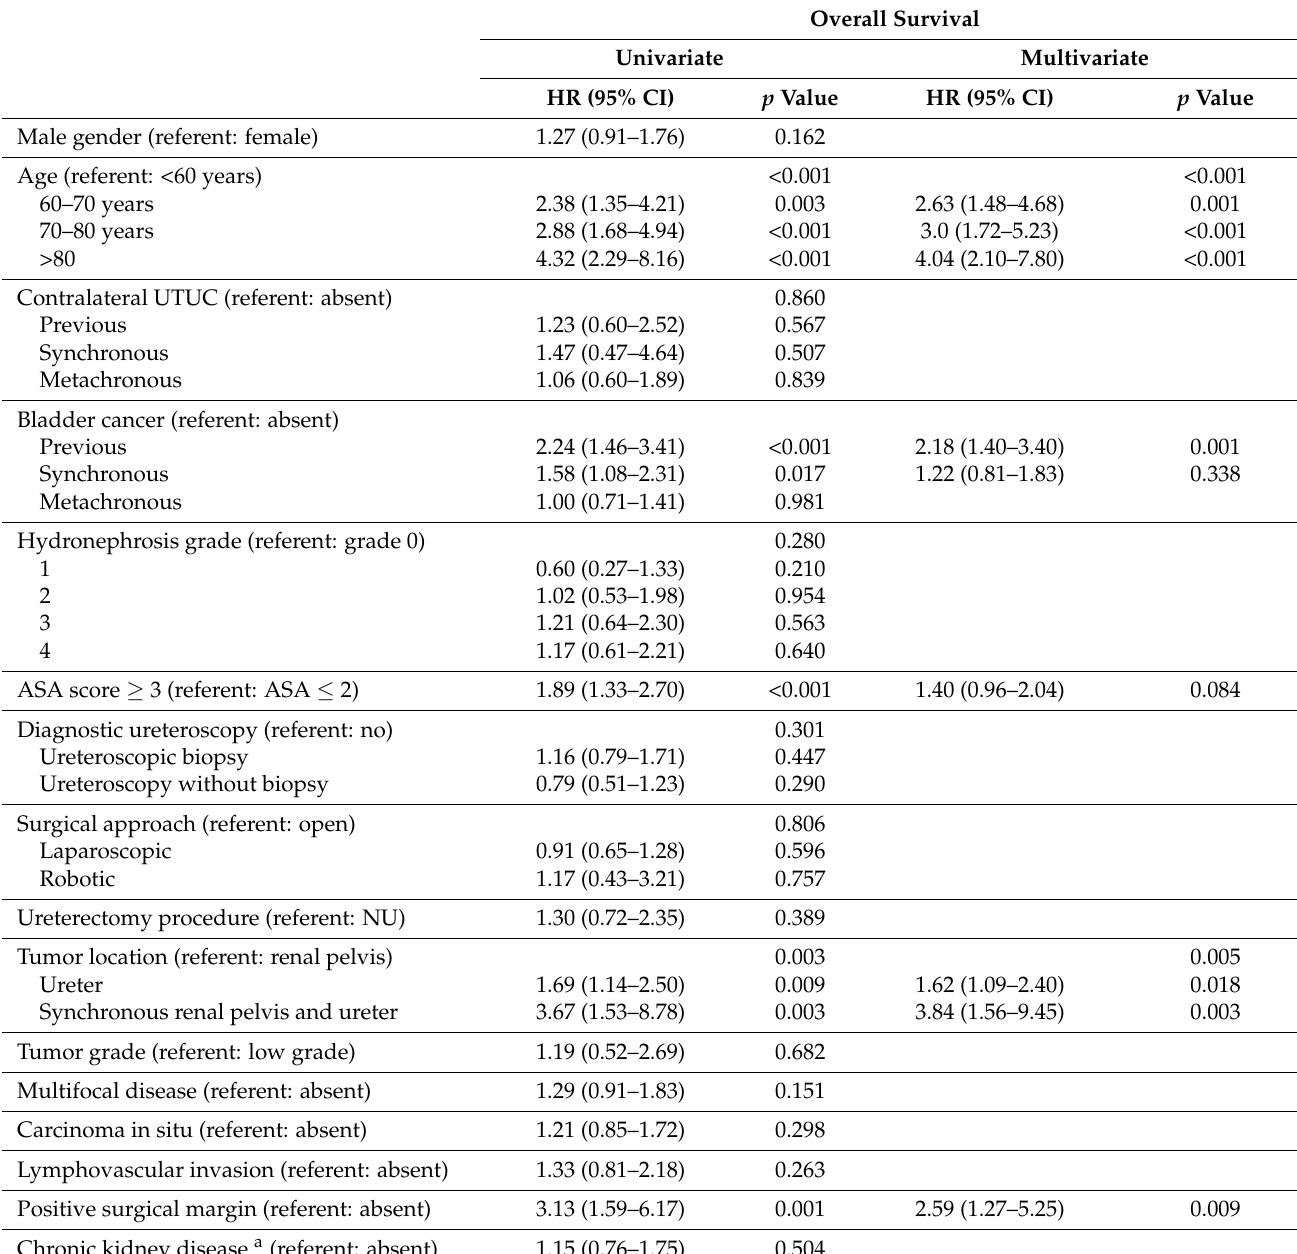
Table 4. Univariate and multivariate analysis predicting prognostic factors for overall survival in the patients with pT2 UTUC after radical surgery. Overall Survival Univariate